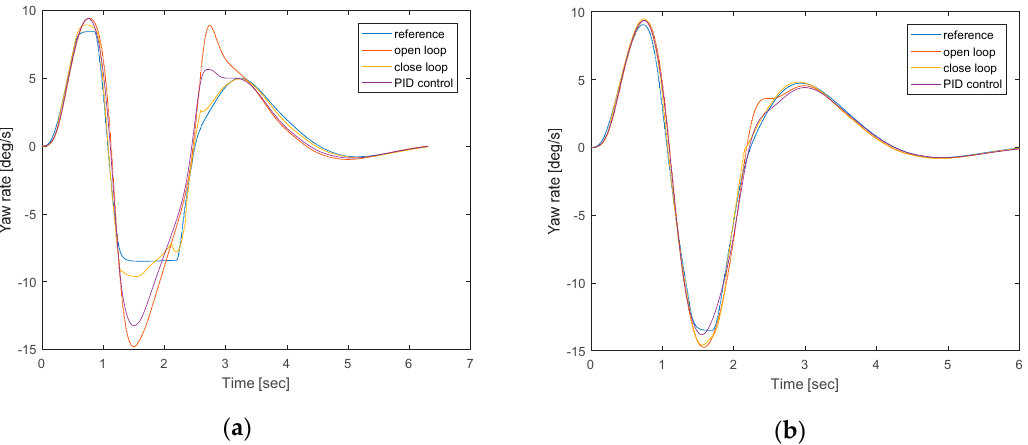
Figure 9. Comparison of yaw rate at 120 km/h with a coefficient of adhesion of 0.5 and 0.8. ( a , b ) reflect the nominal yaw rate, and yaw rate of three control methods at a speed of 120 km/h on a pavement with a pavement adhesion coefficient of 0.5 and 0.8.